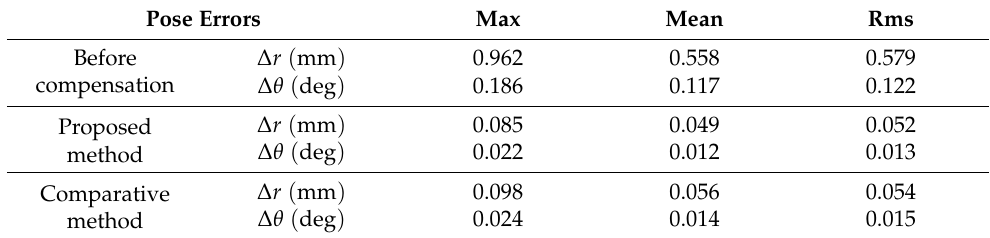
Table 5. Pose errors before and after